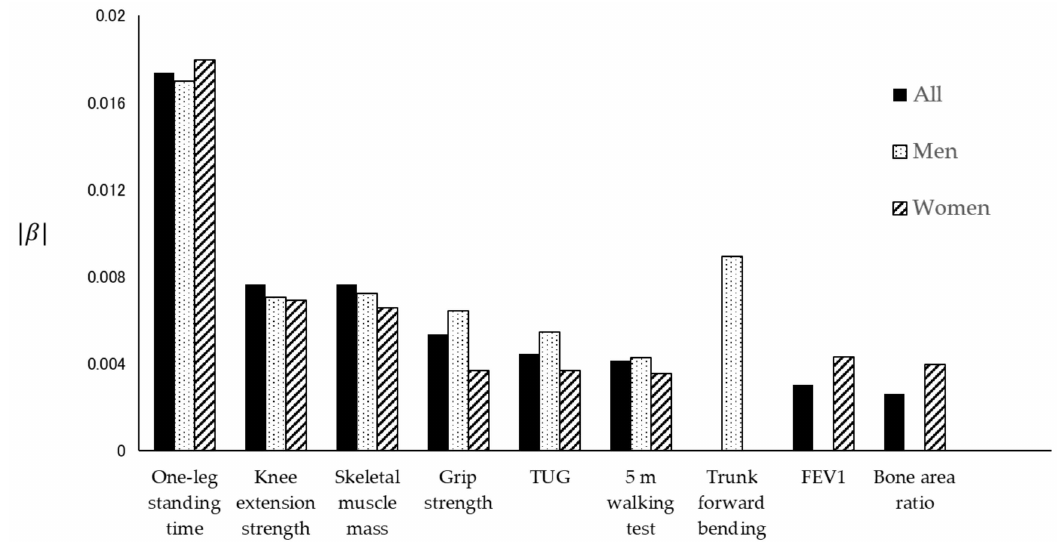
Figure 4. Comparison of the rate of decline in each physical function between all subjects, men, and women. Each bar shows the rate of decline in each physical function. The black bars represent all subjects, the dotted bars represent men, and the diagonally striped bars represent